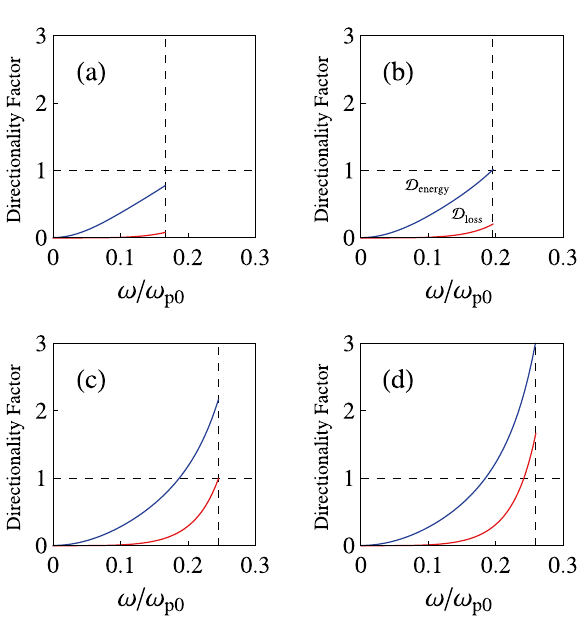
Figure 3. Variation of D energy (blue curves), and D loss (red curves) as a function of the dimensionless frequency ω/ω p0 for a nanowire HMM as type-I HHM (for example a gold nanowire HMM in the visible and near-IR range 28 ). Here, the permittivity ε m of the metal is characterized by the Drude model and for the dielectric we use ε SiO 3.9 . For the other parameters we consider ε SiO 2 with ε d 2 = = ω 2 γ 2 . The different panels refer to ( a ) f dashed line shows ω p = � − 0.22 ( d ) f (cid:31) =